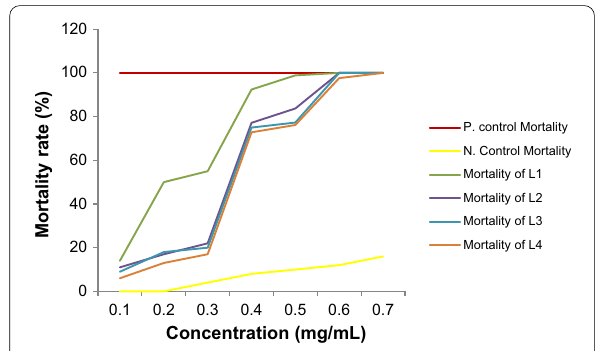
Fig. 1 Larval mortality based on concentrations of extract of Calotropis procera after 24 h of